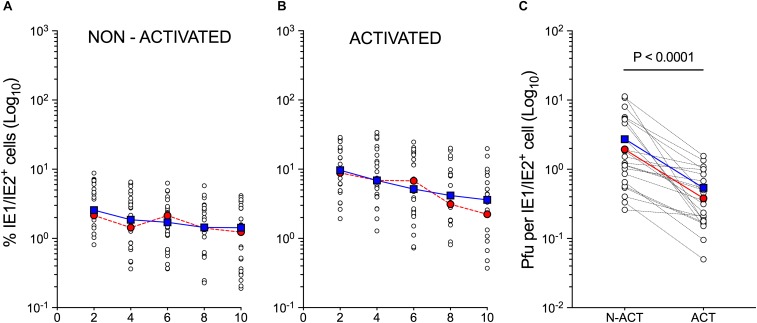
Susceptibility to CMV infection of non-activated and activated myeloid cell populations differentiated from cord blood CD34+ HSC. Non-activated and activated myeloid cell populations differentiated from the CD34+ HSC of twelve different cord blood donors were exposed to CMV strain TB40/E at an MOI of 10 and analyzed at days 2, 4, 6, 8, and 10 pi. (A,B) Percentage of IE1/IE2+ cells (Log10) present in each population as determined by immunofluorescence staining analyses. (C) Peak (days 6–10) intracellular progeny yields as quantified by titration assays of cell sonicates from paired cultures of non-activated (N-ACT) and activated (ACT) cell populations. Open circles represent data from individual donors obtained in separate experiments. Some donors were used more than once. Blue squares indicate median values at each time point. Red circles depict data obtained from the CD34+ HSC of representative donor 113G.